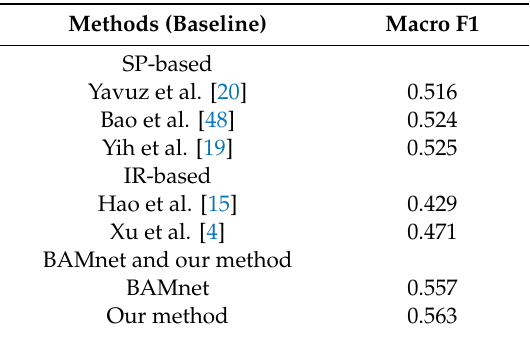
Table 1. Results on the WebQuestions test